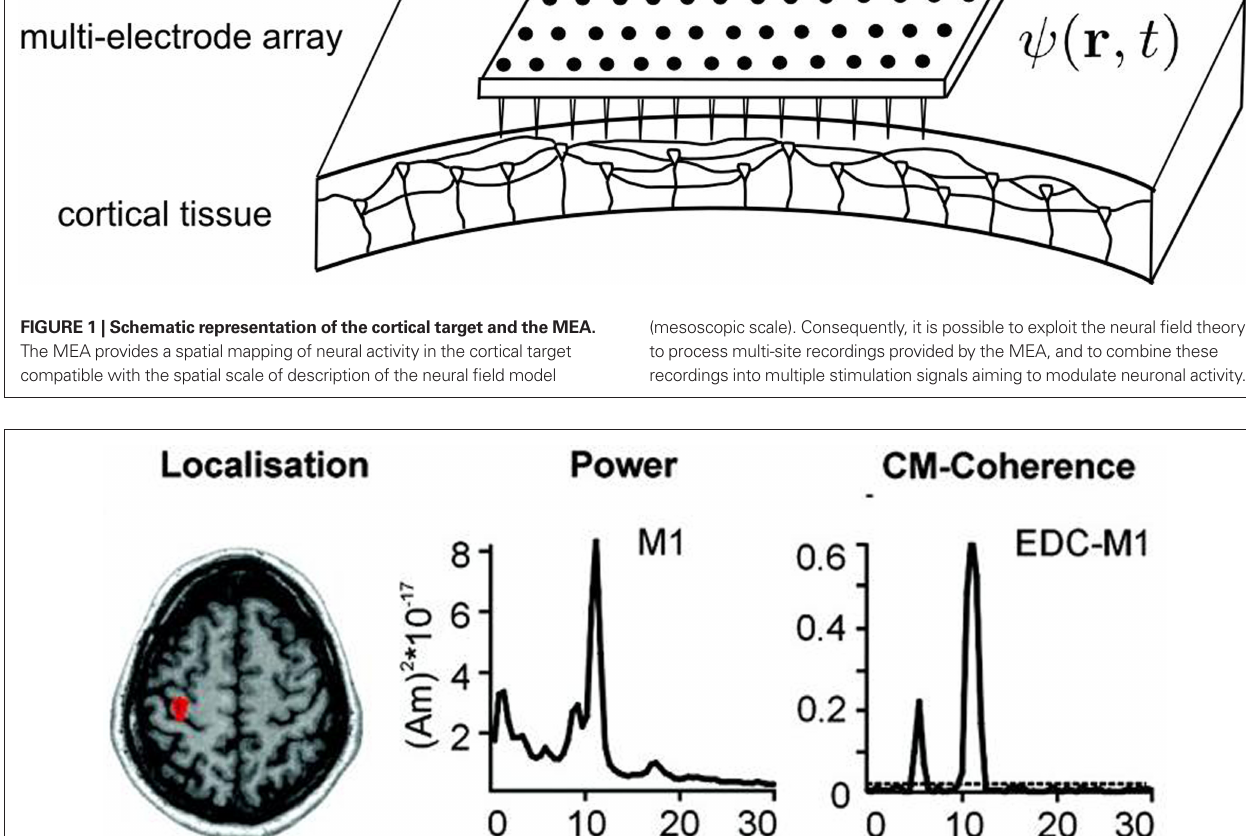
spectrum of M1 MEG recording presents a strong peak centered around 10 Hz (middle). Cerebro-muscular (CM) coherence between M1 activity as measured by MEG and EMG of the Extensor Digitorum Communis (EDC) has a maximum around 10 Hz (Fig. modified from Timmermann et al., 2003, with